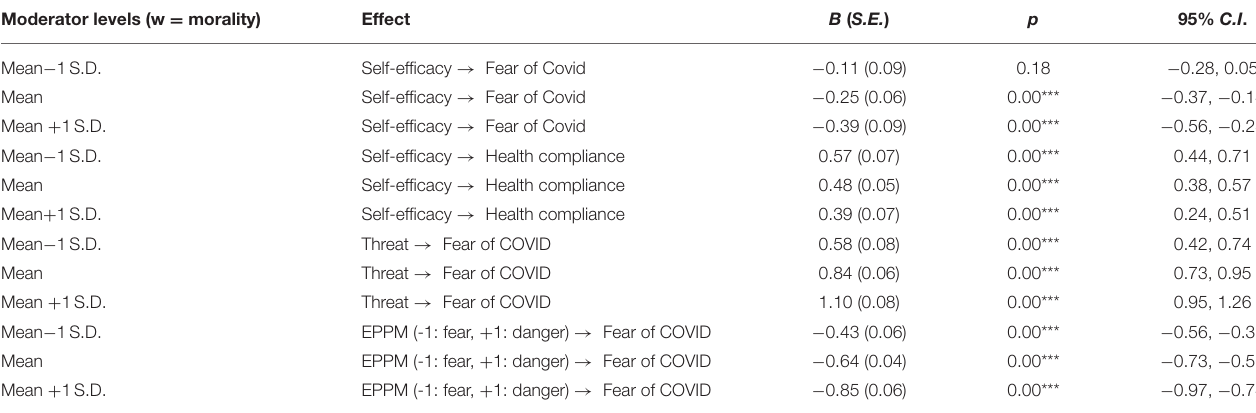
TABLE 2 | Conditional effects morality as a moderator. Moderator levels (w =